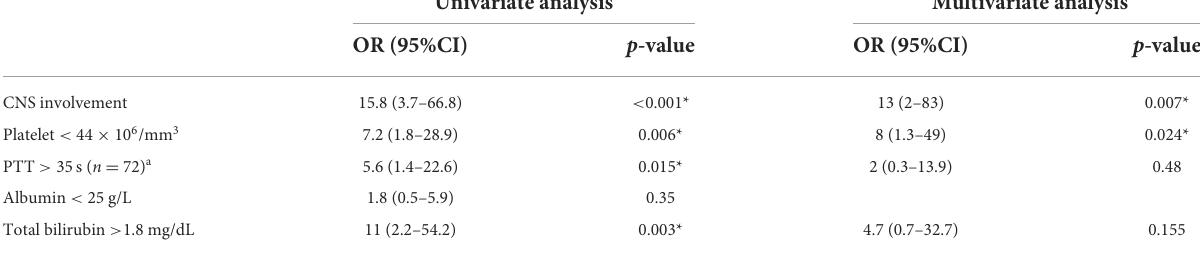
TABLE 3 Predictors of early mortality in HLH patients.